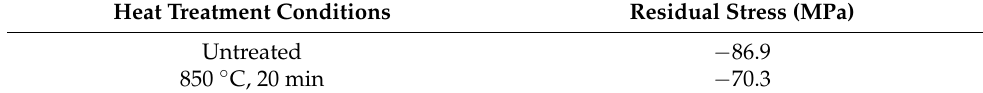
Table 4. Residual stress estimated using a micro-area X-ray residual stress measurement system.